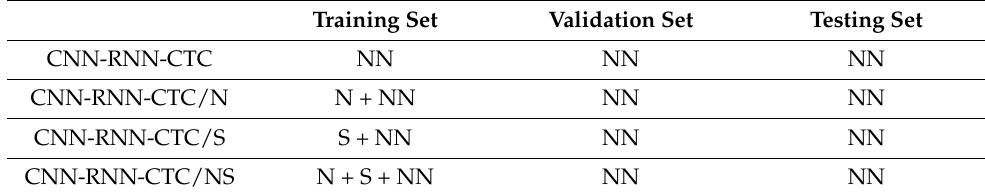
Table 9. End-to-End MDD models for non-native Arabic speech. N: native speech; S: synthesized speech; NN: non-native speech. Training Set Validation Set Testing